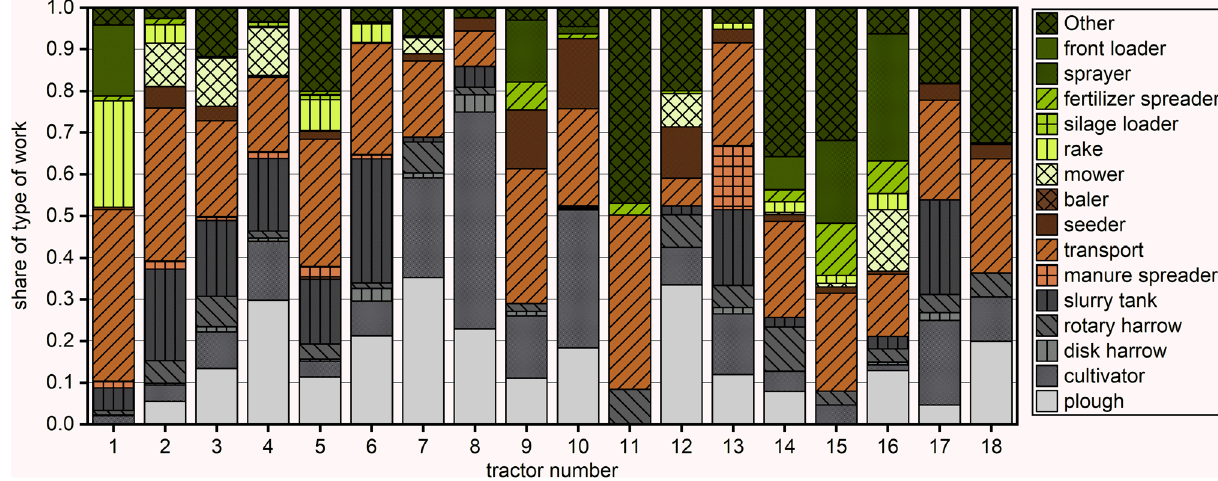
Fig. 1 Share of types of works of the tractors for the years 2015 to 2017